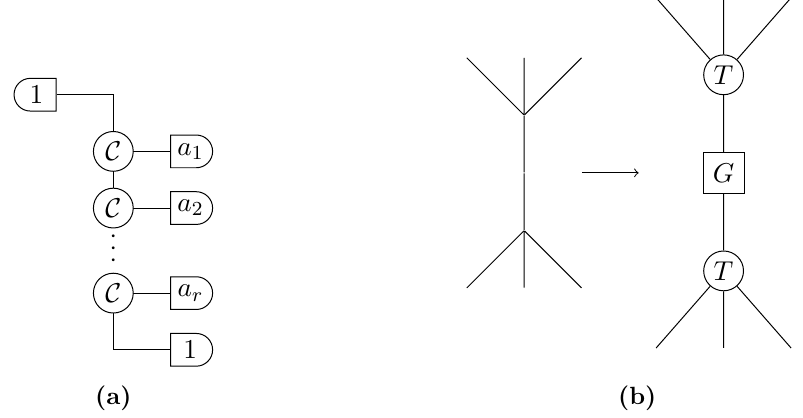
a from bc . (b) Tensor network associated 1 (cid:1)(cid:1)(cid:1) a r C and the box denotes contraction with G ab abcd